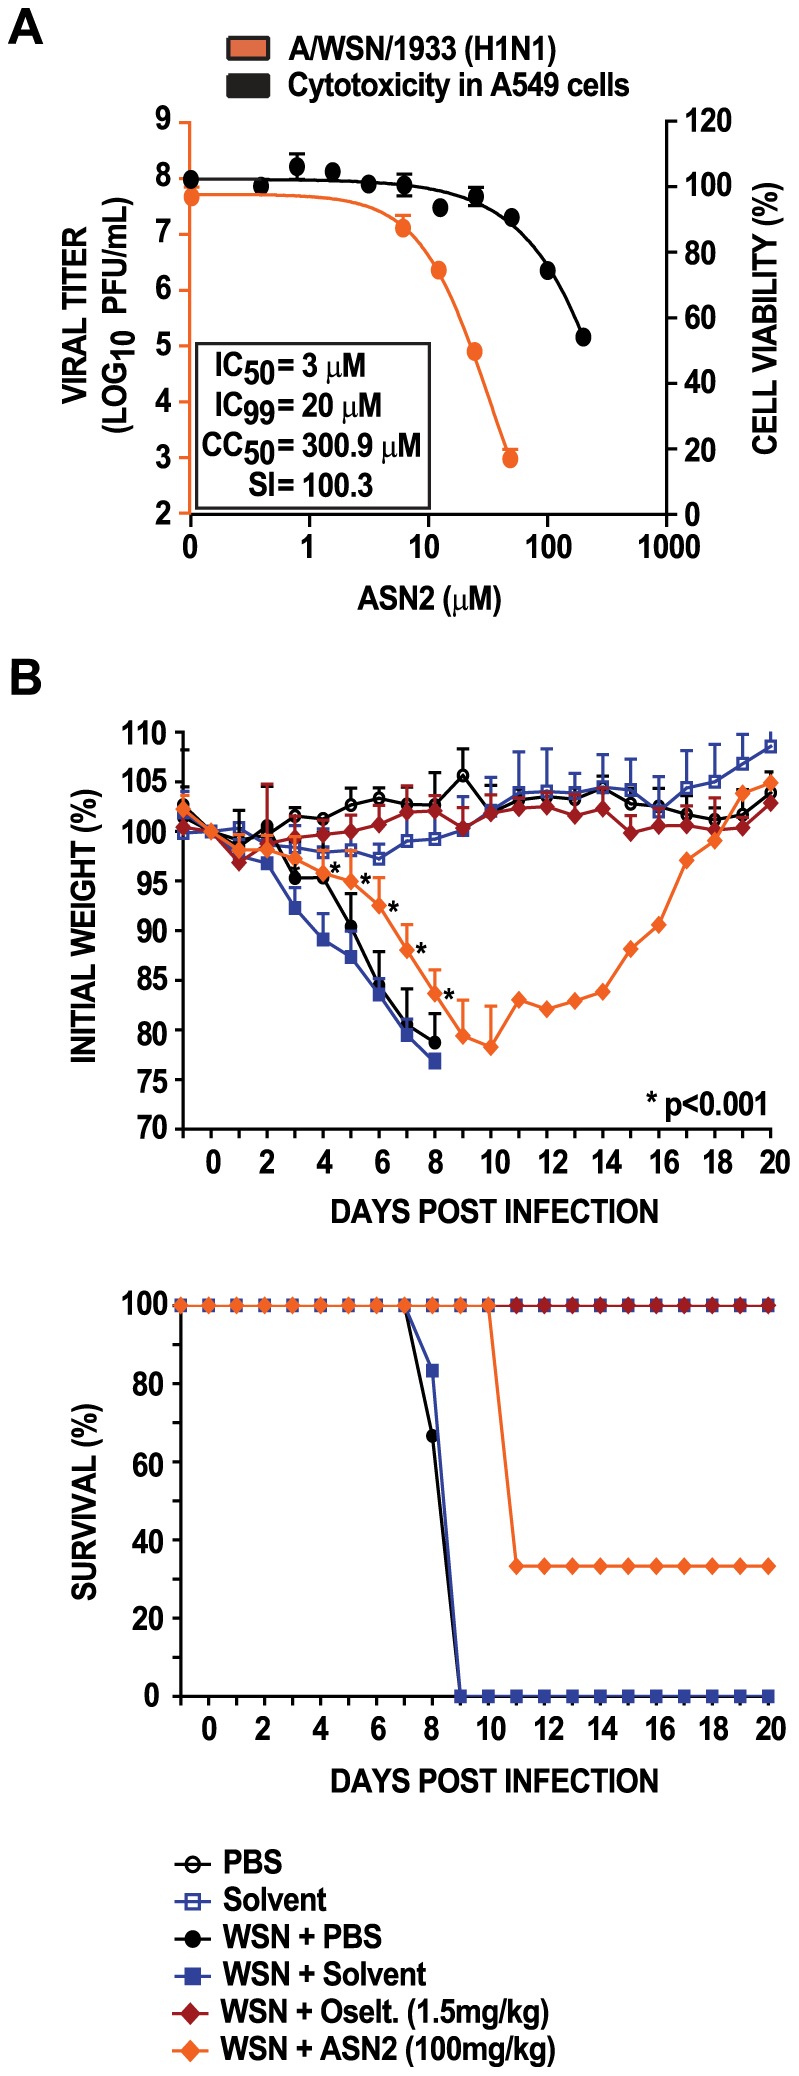
ASN2 inhibits the replication of influenza A virus and displays in vivo antiviral activity.(A) Virus titers from A549 cells infected with influenza A/WSN/33 virus (MOI = 0.01) and treated with increasing concentrations of ASN2 for 48 hours (orange curve). Cell viability analysis of A549 cells treated with increasing concentrations of ASN2 for 48 hours (black curve). Curves represent means of triplicate values ± standard deviation. (B) Bodyweight and survival curves of BALB/c mice (groups of 9) infected with influenza A/WSN/33 virus (5LD50) and treated with 100 mg/kg of ASN2 every 8 hours for 8 days. Compound was delivered intraperitoneally beginning 8 hr prior to infection. Three mice from each group were sacrificed on days 3 and 8 post infection to determine viral lung titers (data not shown). Curves represent means ± standard deviation, *p<0.001. Mice that fell below 75% of their initial weight were sacrificed in accordance with our animal protocol.